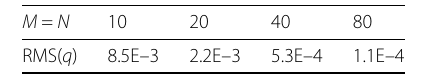
Table 1 The RMS error norm for direct